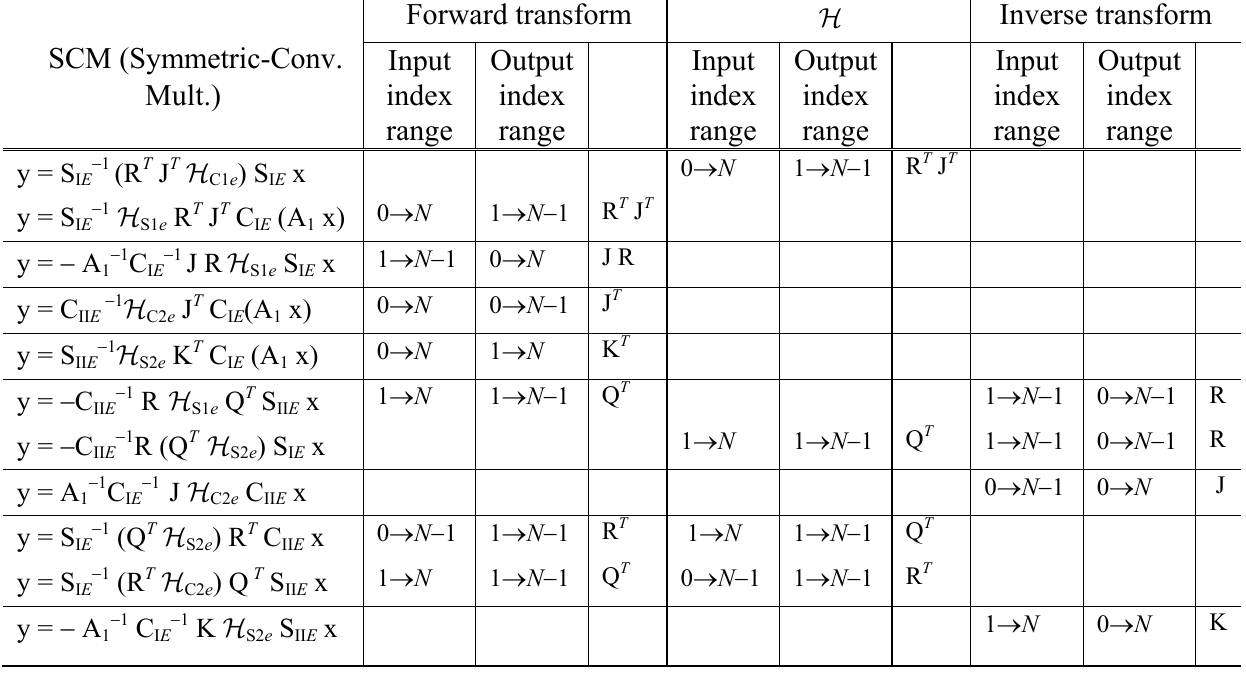
Table 1. Link between the index range-based maneuvers described by Martucci [2] and the introduction of the J, K, Q and R matrices, M = 2 N .